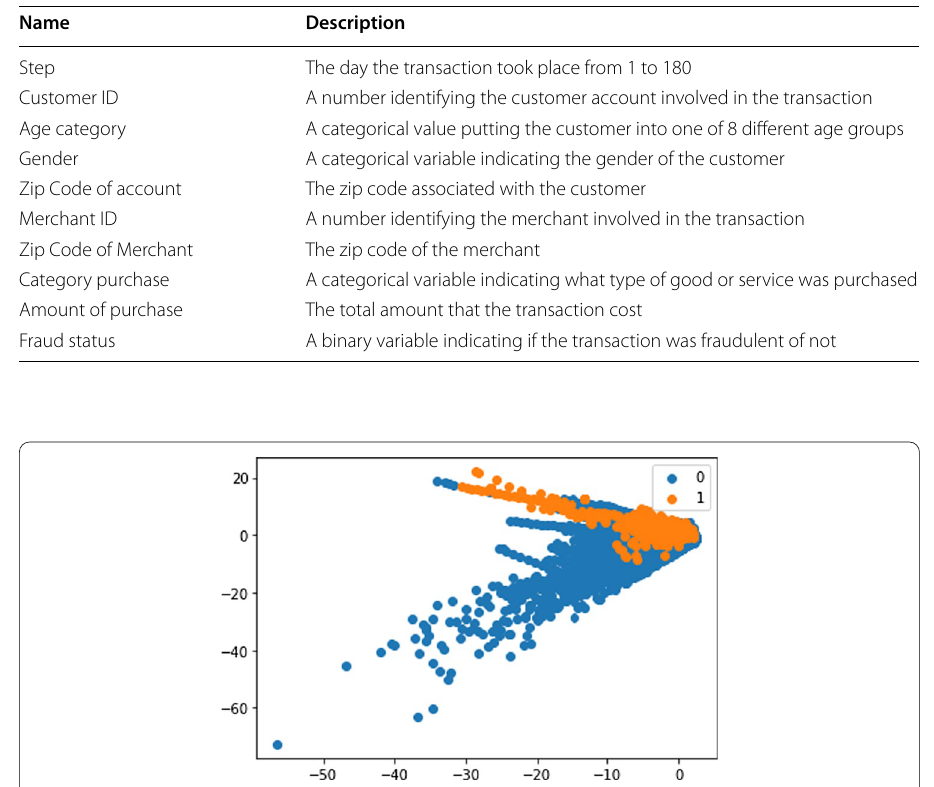
Fig. 5 Plot of credit card dataset before SMOTE